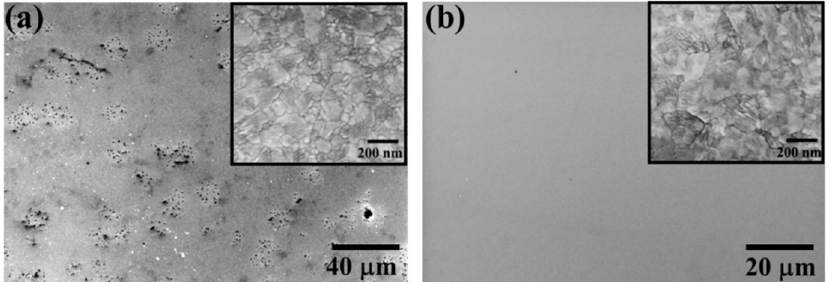
Figure 2. Low magnification SEM images of W films on ( a ) LGS and ( b ) CTGS post ‐ annealing at 800 °C for 12 h under vacuum (high ‐ magnification images are shown in the inset).